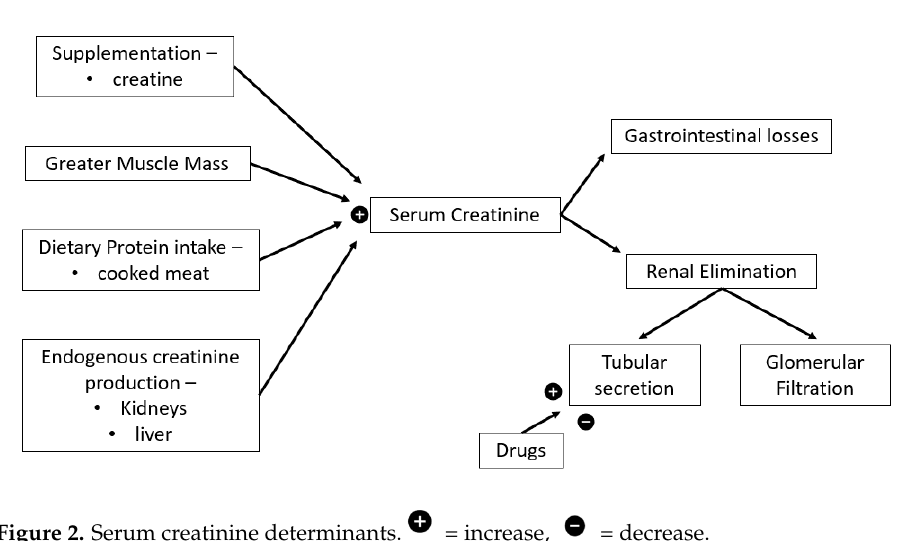
Figure 2. Serum creatinine determinants. = increase, = decrease.